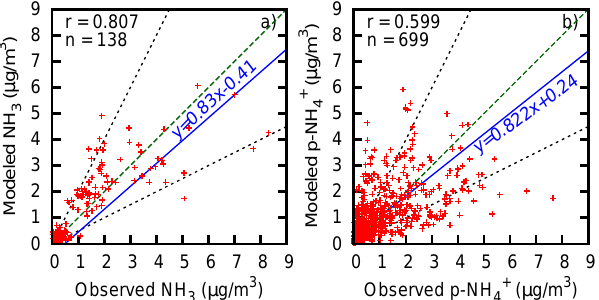
Fig. 4. Correlations between measured and modeled weekly NH 3 concentrations (µg m − 3 ) for six sites (left) and 24-h p -NH + concentrations (µg m − 3 ) for four sites during the simulation period from 1 June to 30 November 2006. The black dotted lines show agreement within a factor of 2. Fitted regression (blue solid) lines and 1 : 1 (darkgreen dashed) lines are also plotted.